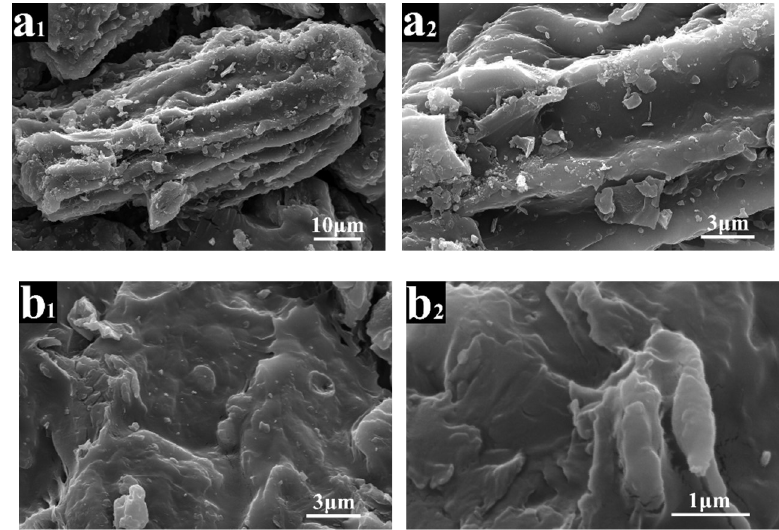
Figure 1. Scanning electronic microscopy (SEM) images of almond shell biochar (ASB) ( a 1 , a 2 ) and PEG/ASB CPCM with 60% theoretical PEG content (CPCM3) ( b 1 , b 2 ).